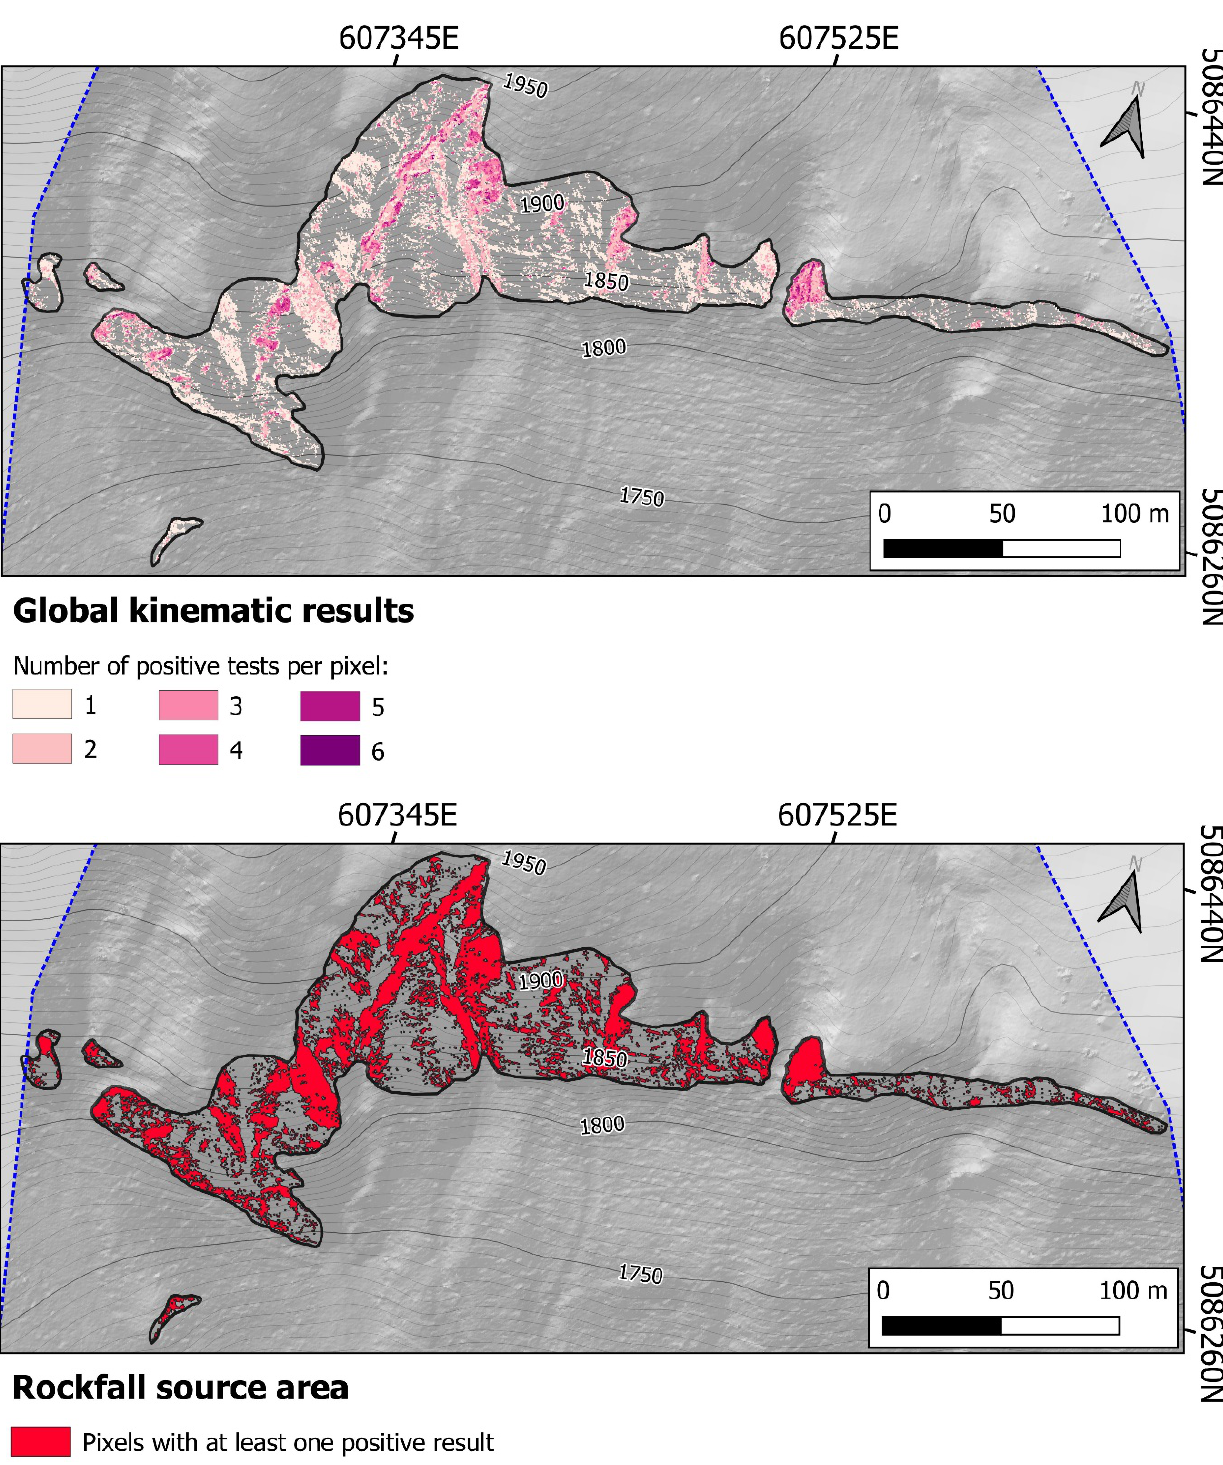
Figure 12. ( above ) Image of the S matrix, showing the distribution of all kinematic test results: most of the rock faces could produce at least one or two possible movement types. Only in localized areas up to six movement types are possible in the same pixel; ( below ) image of the extracted source areas for rockfall 3D simulations converted to shapefile using the r.to.vect tool of the GrassGis repository, available in QGis; the surface covered by these source area polygons amounts to 38.9% of the total surface of the rock